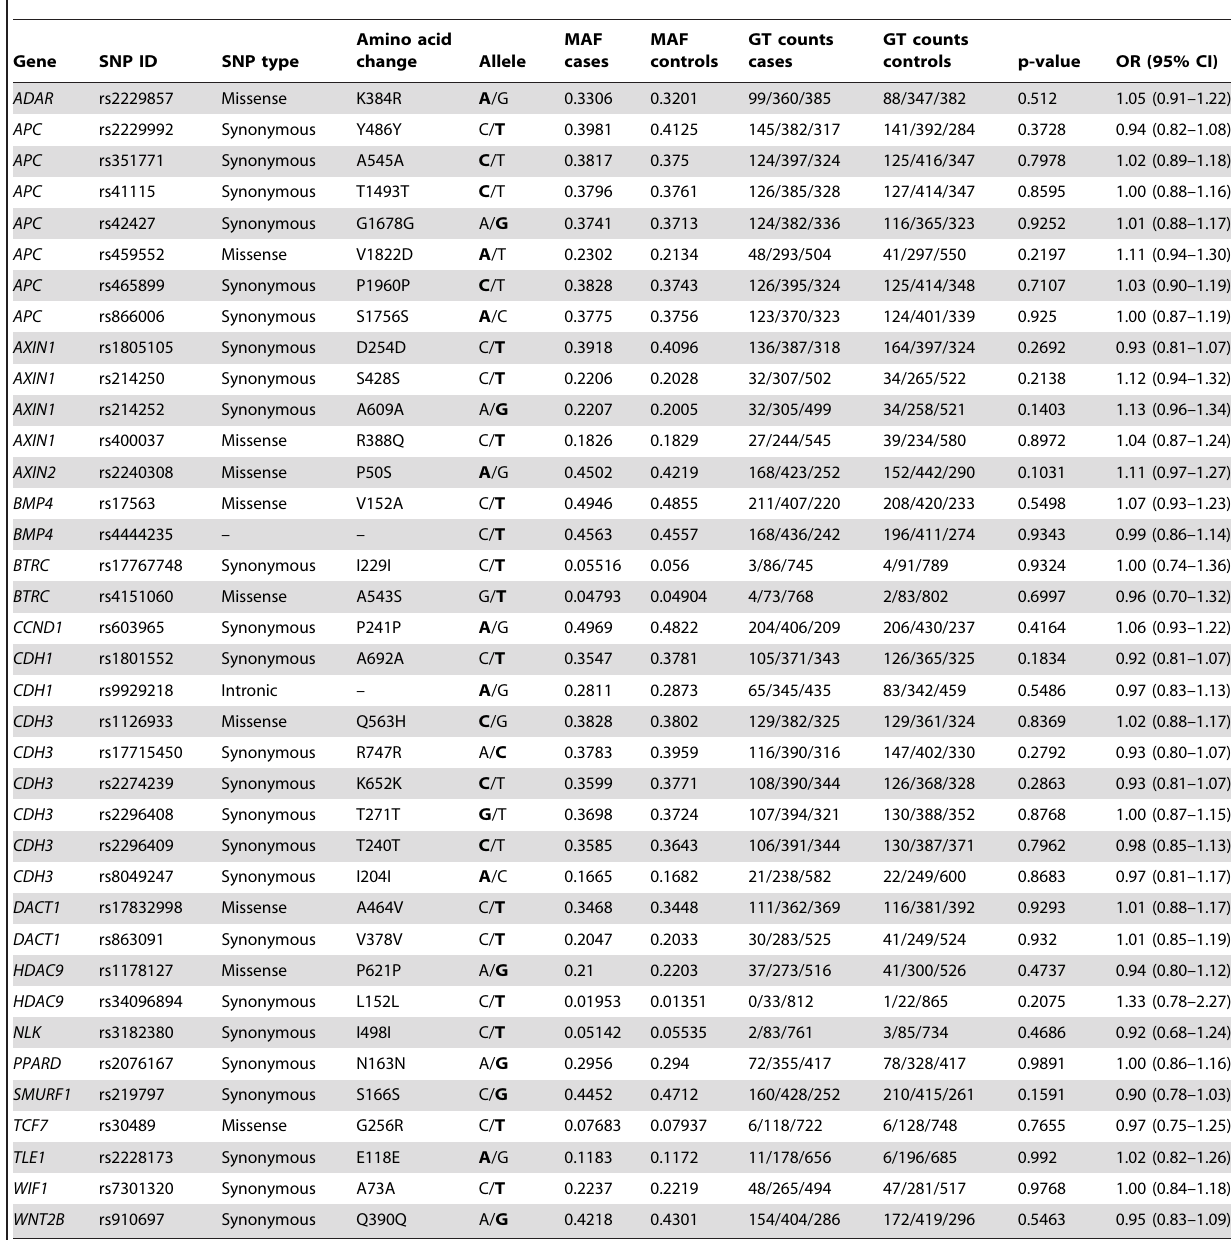
Table 1. Description of the 37 SNPs that passed quality control criteria and their associated p values.